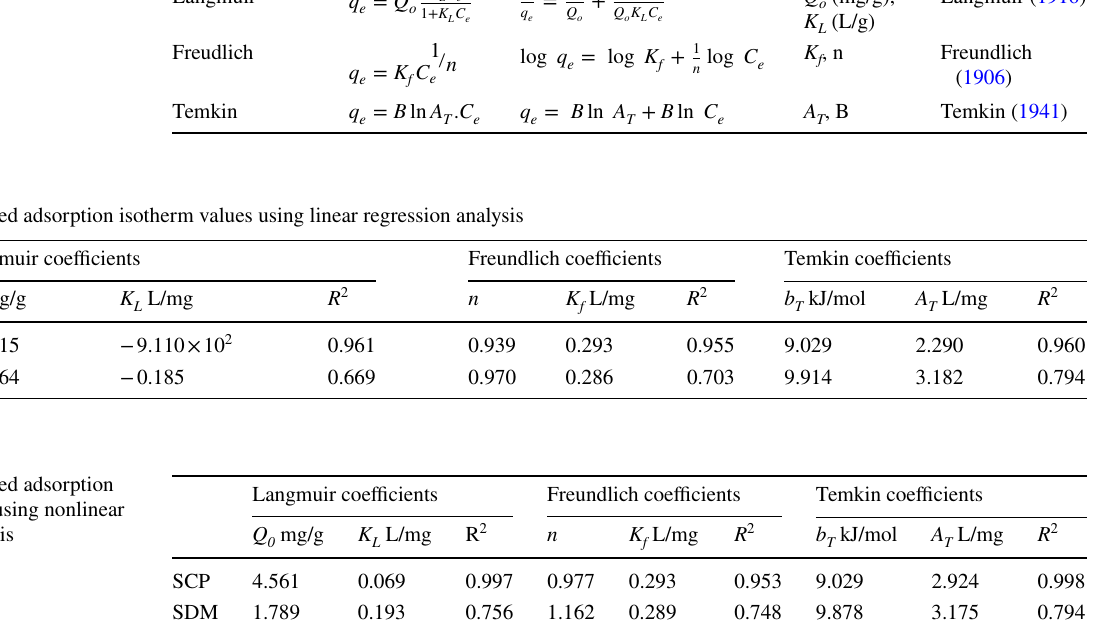
Table 4 Linearized isotherm equations and parameters